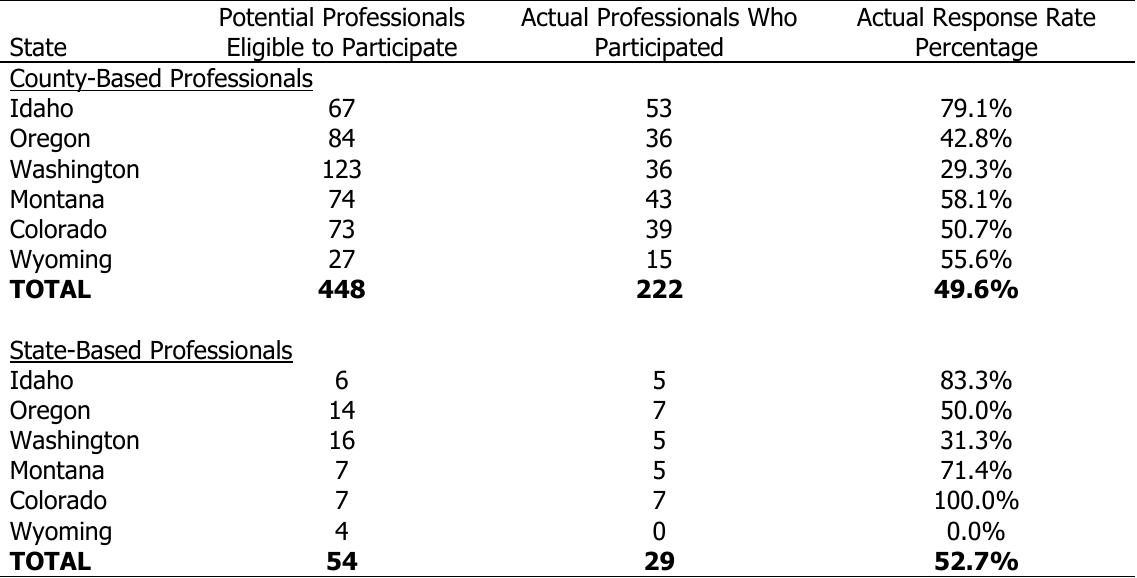
Potential and Actual County-Based and State-Based Participants